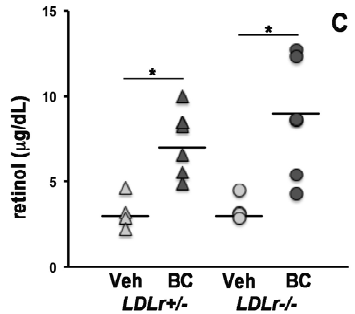
Figure 1. β ‐ carotene and retinoid levels in the serum of Ldlr +/ − and Ldlr − / − pregnant mice administered β ‐ carotene at 13.5 dpc. Analysis by HPLC and concentrations expressed as μ g/dL. ( A ) β ‐ carotene (BC); n = 7/group; ( B ) retinyl ester; n = 4 for Ldlr +/ − + vehicle (veh), n = 7 for Ldlr +/ − + BC, n = 4 for Ldlr − / − + veh, and n = 6 for Ldlr − / − + BC; ( C ) retinol; n is same as in ( B ). Individual measurements are shown. Statistical analysis by Kruskal–Wallis test; * p < 0.05.